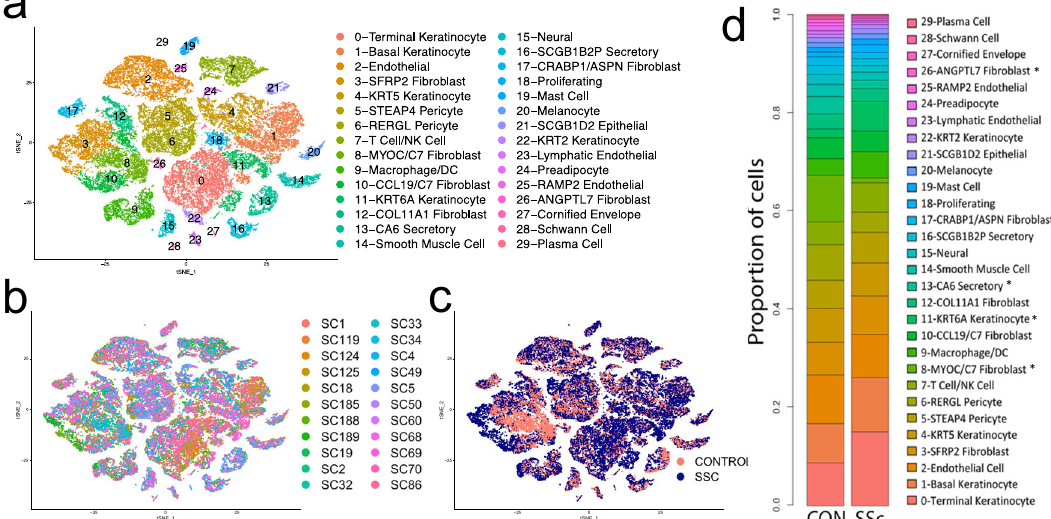
Fig. 1 T -SNE plot of scRNA-seq data from control and SSc skin biopsies. Transcriptomes of all cells obtained after enzymatic digestion of dorsal mid- forearm skin biopsies from 10 healthy control and 12 SSc subjects, showing each SLM cluster by color ( a ) or by source from each patient ( b ) or by source form SSC (blue) or control (red) biopsies ( c ). The proportion of cells in each cluster is indicated ( d ). Cell populations are differentially expressed between the SSc and control groups ( p < 0.001, chi square test). Stars (*) indicate different proportions between SSc and control subjects, ( p <